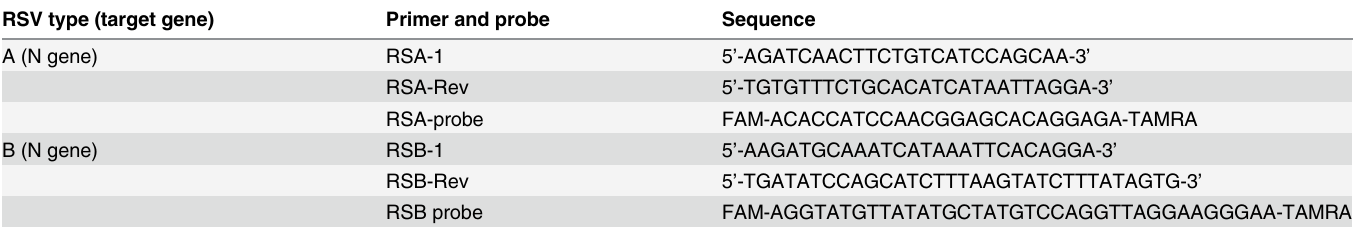
Table 1. Primers and probes for the TaqMan real-time PCR used to detect viral RNA from RSV-A and B. RSV type (target